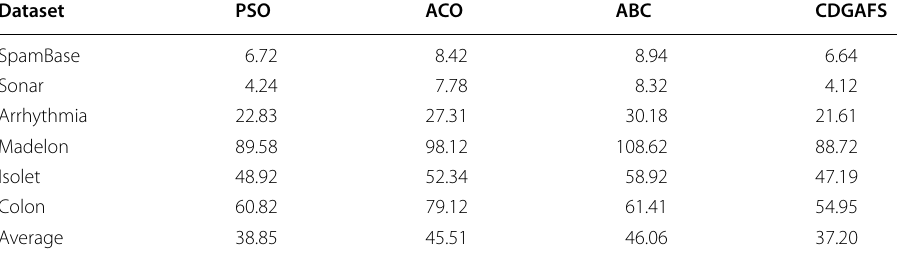
Table 5 Average execution time (in second) of wrapper feature selection methods over ten independent